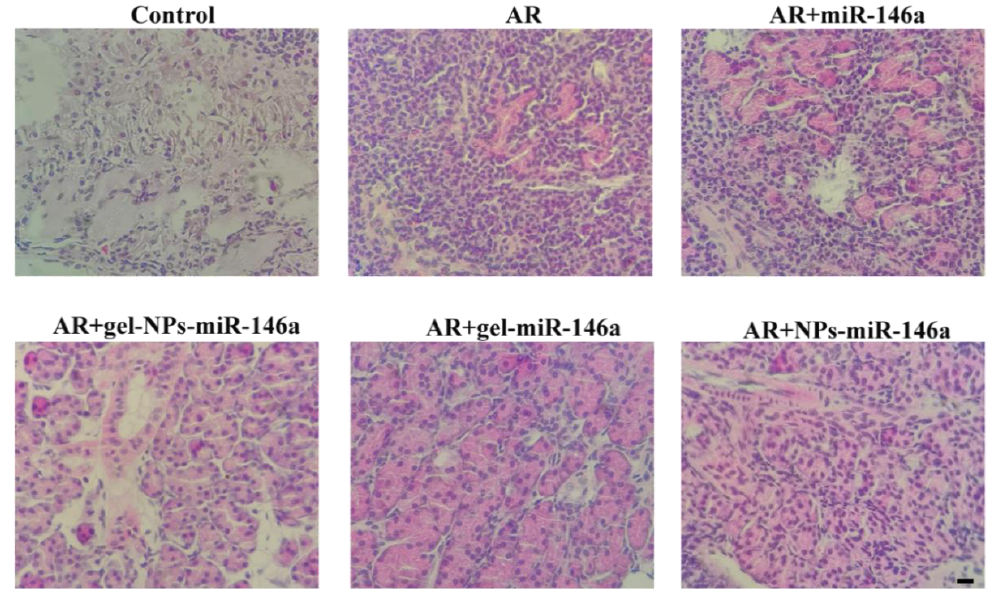
Figure 9. Histopathological changes in the nasal mucosa of rats were investigated by hematoxylin-eosin (HE) staining (400×).